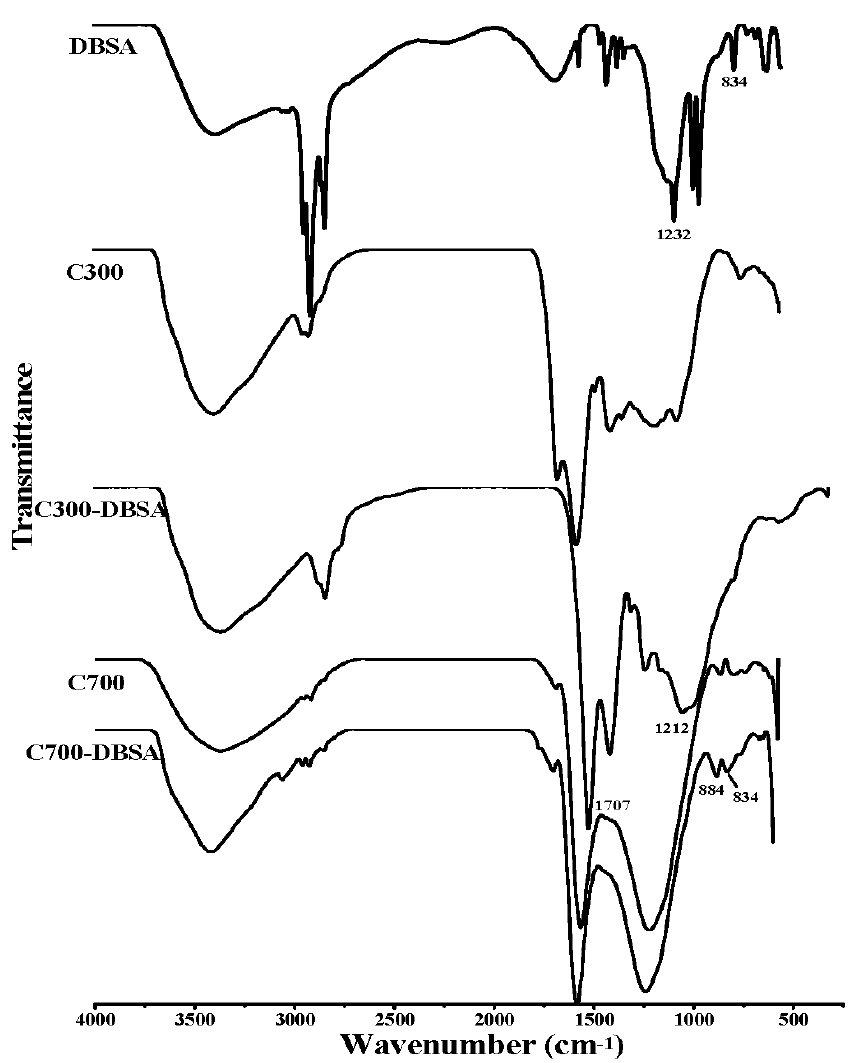
Figure 5. Infrared (IR) spectra of DBSA, crop straw biochars and their interaction complexes.